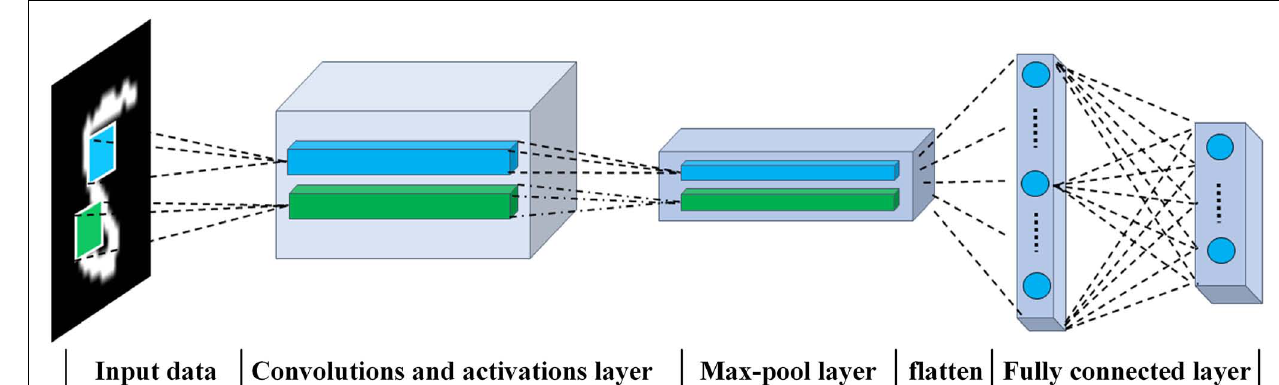
FIGURE 1 | A typical architecture of convolutional neural